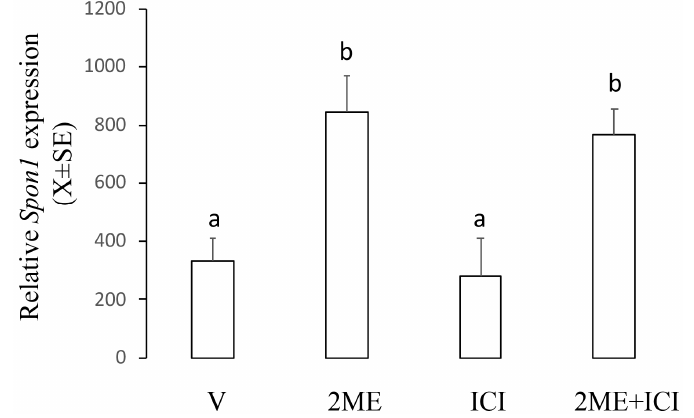
Figure 5. Levels of Spon1 in the Ishikawa cells treated with 2ME alone or concomitant with the estrogen receptor antagonist ICI182780 (ICI). V is the control group. This experiment consisted of 5 replicates. a b, p < 0.05. Note that ICI did not affect the 2ME ‐ induced Spon1 increase.